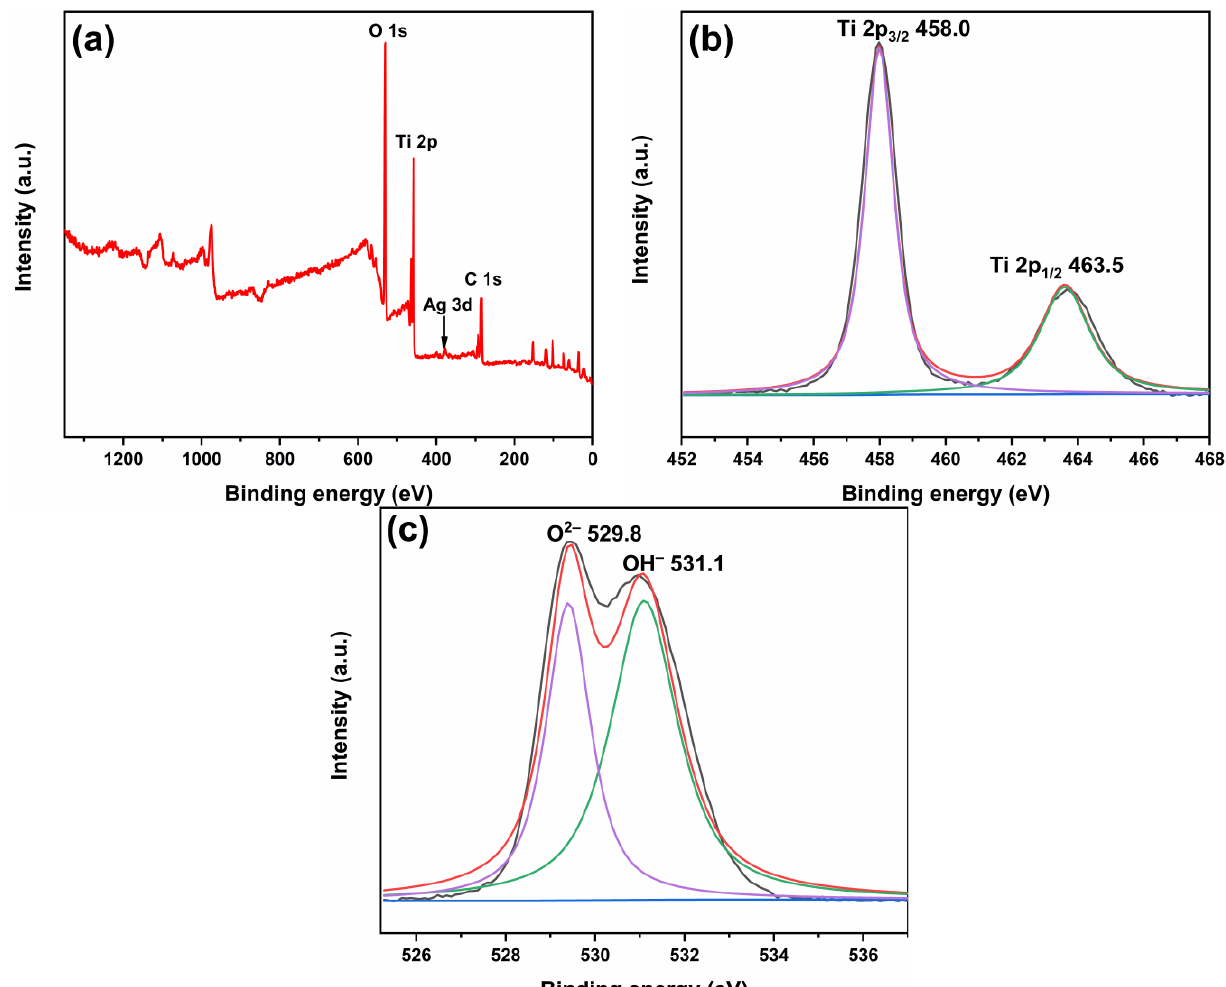
Figure 5. XPS spectra of 1-ATM: total spectrum ( a ), Ti 2p ( b ) and O 1s ( c ).